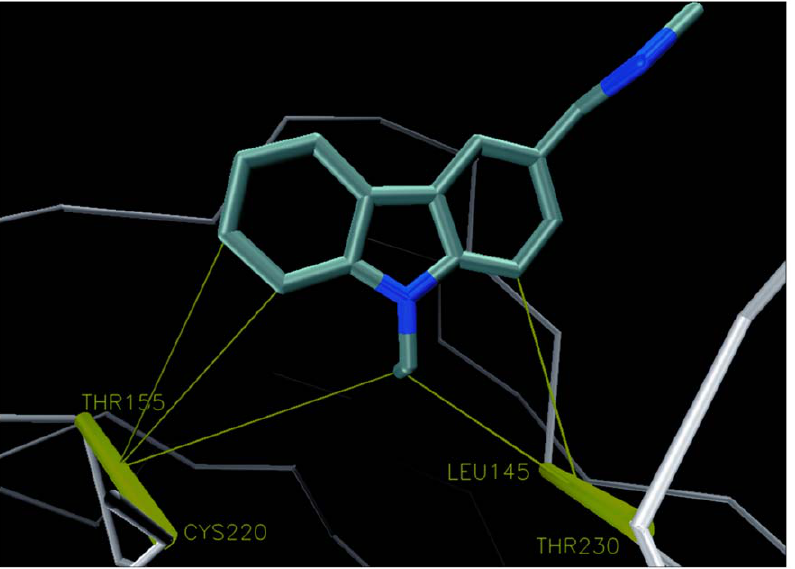
Figure 1. T-p53C-Y220C in complex with PhiKan083 (pdb: 2VUK). Dehydrons in the protein are depicted by green bars joining the two residues paired by the HB, while green thin lines are wrapping interactions with the small molecule.